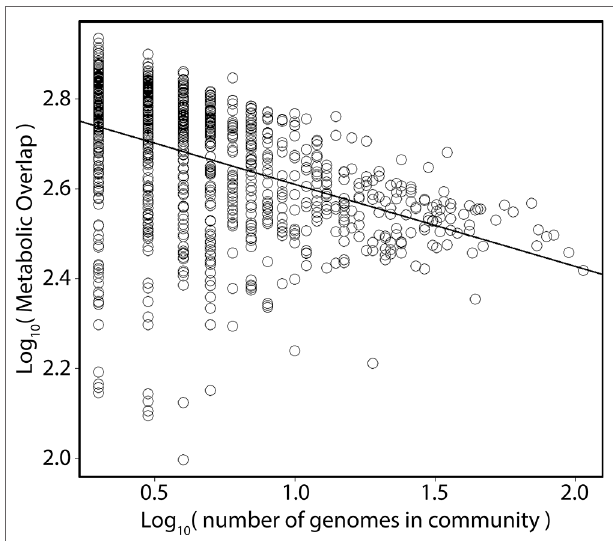
FIGURE 2 | Relationship between metabolic overlap and the number of genomes in a community. Each point represents one of the 962 studies. The x axis depicts the total number of MAGs in a given study; the y axis, the mean metabolic overlap of that